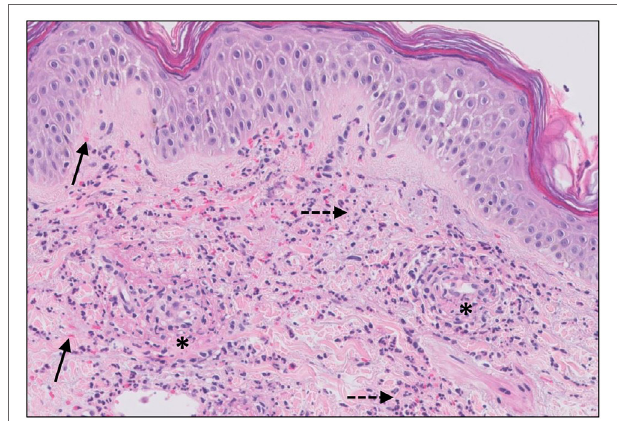
FigURe 4 | Small vessel leucocytoclastic vasculitis. The section shows all features of leucocytoclastic vasculitis. A mixed inflammatory cell population surrounding the postcapillary venules of the superficial dermis. The infiltrate consists of neutrophils with nuclear dust (dashed arrows) and shows high affinity for the vessels. Features of vascular injury are shown including fibrinoid necrosis (asterisks) and erytrocyt extravasation (solid